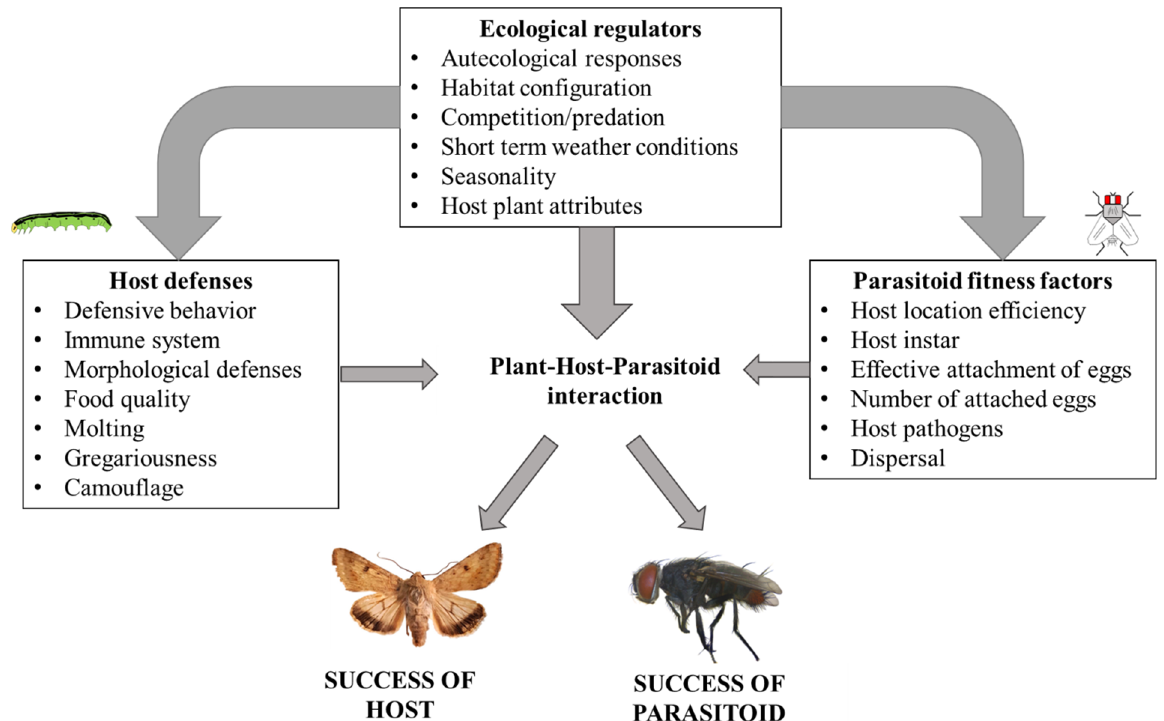
Figure 10. Simplified diagram of potential factors influencing the success of CEW and tachinid parasitoids. Arrows show the direction of regulation, where ecological factors, parasitoid fitness and host defenses influence the outcome of the tritrophic interaction. More complexity could be included since factors interact to determine fitness outcomes of plant-host-parasitoid interactions.